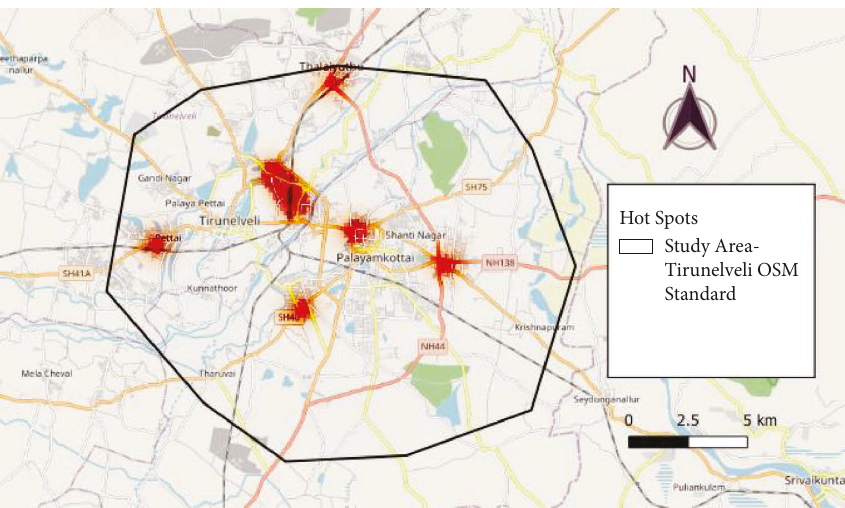
Figure 4: Density map showing the accident blackspots. Table 3: Blackspot location and number of